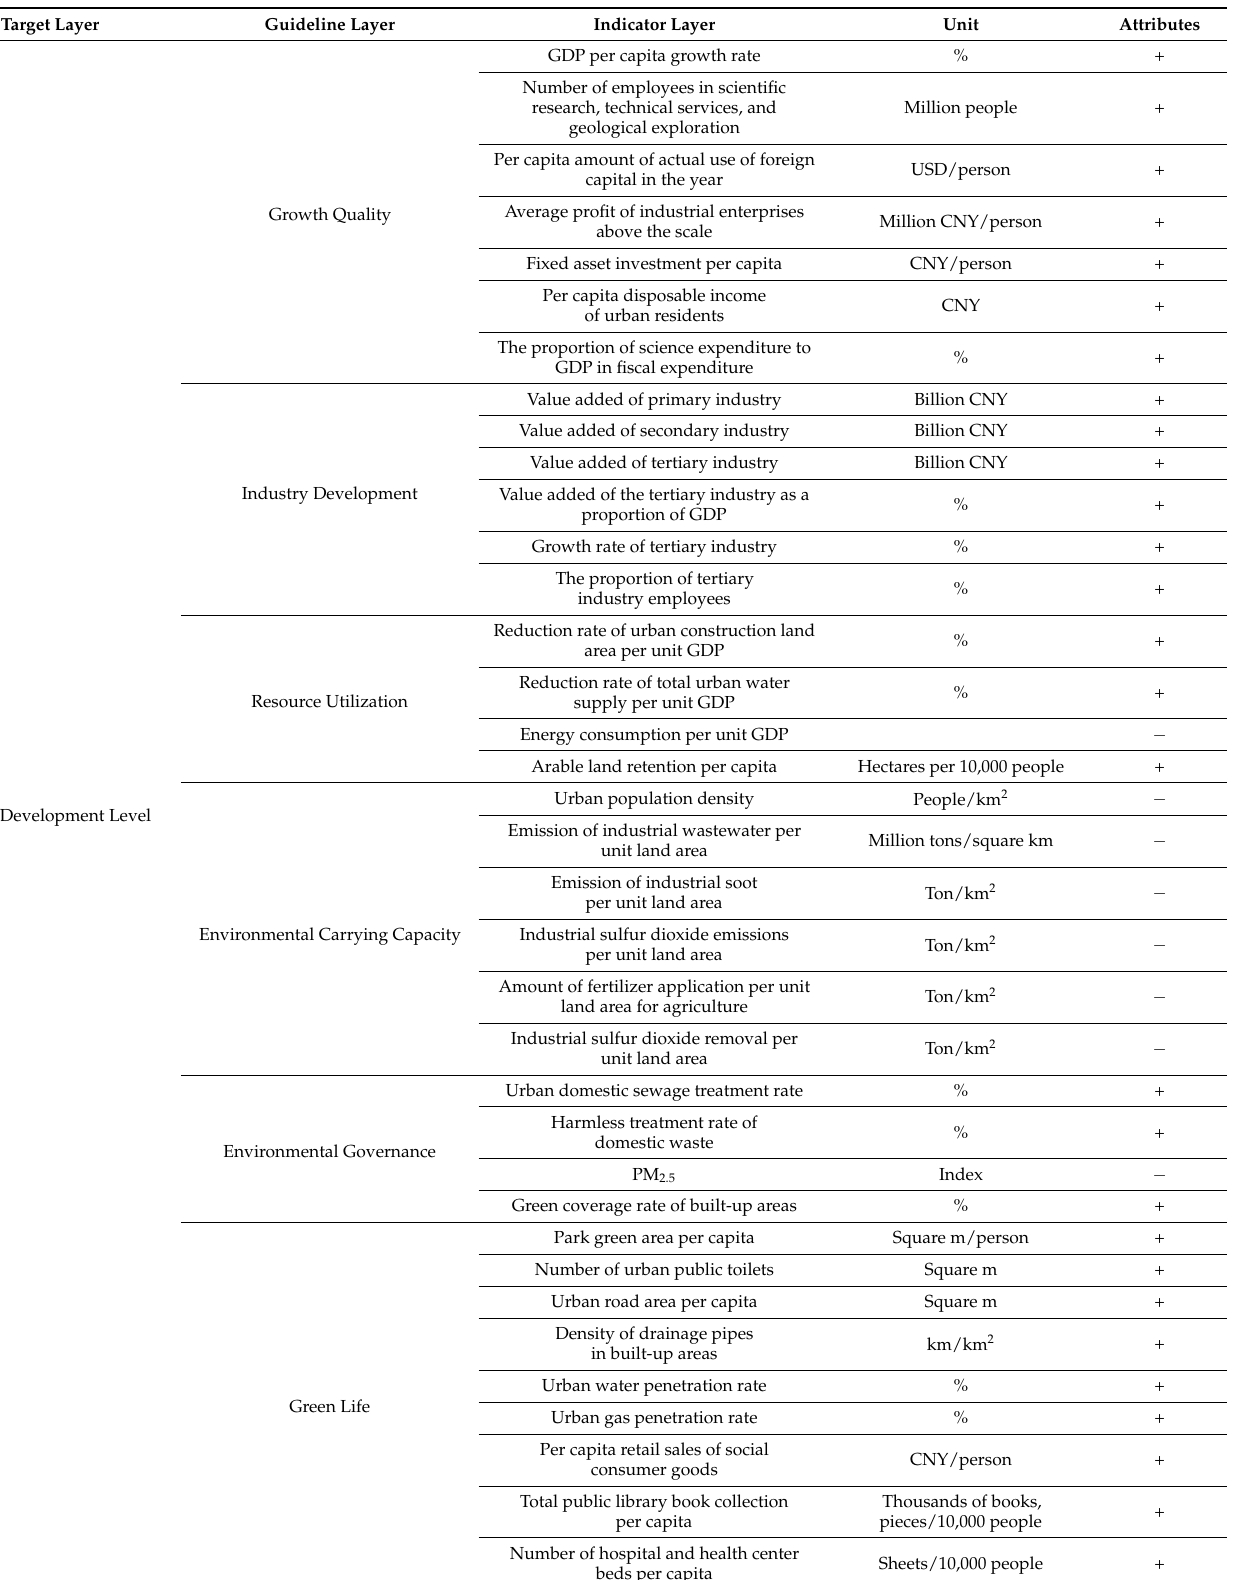
Table 1. Evaluation Index System for Green Development